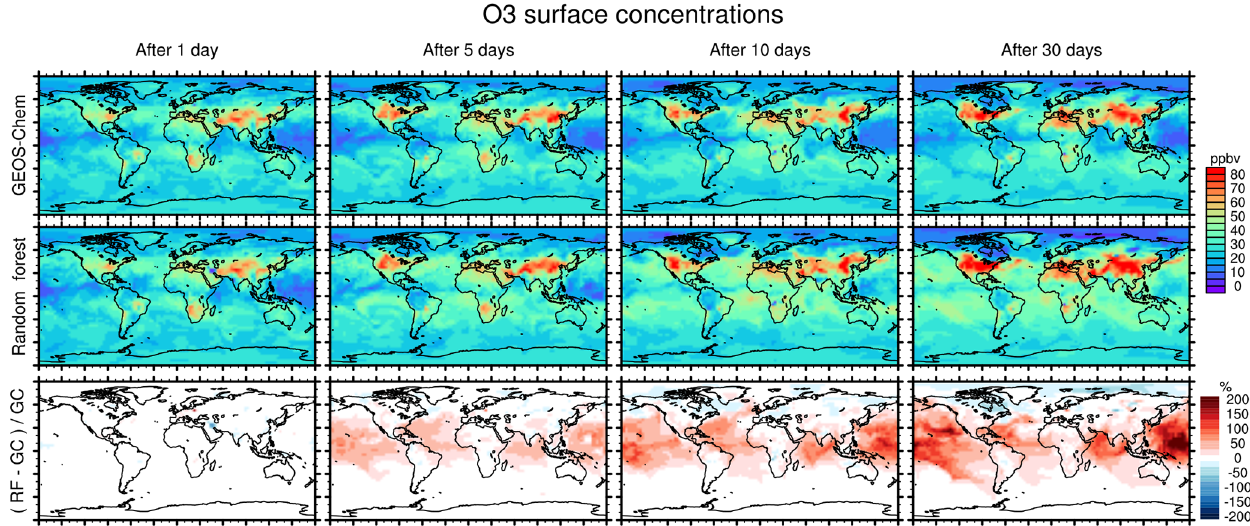
Figure 7. Concentration maps of surface O 3 mixing ratio after 1 simulation day (column 1), 5 simulation days (column 2), 10 simulation days (column 3) and 30 simulation days (column 4), as calculated by the full GEOS-Chem model (row 1) and the standard random forest (RF) model with the NO x family treatment (row 2). Row 3 shows the percentage difference between the RF simulation and GEOS-Chem